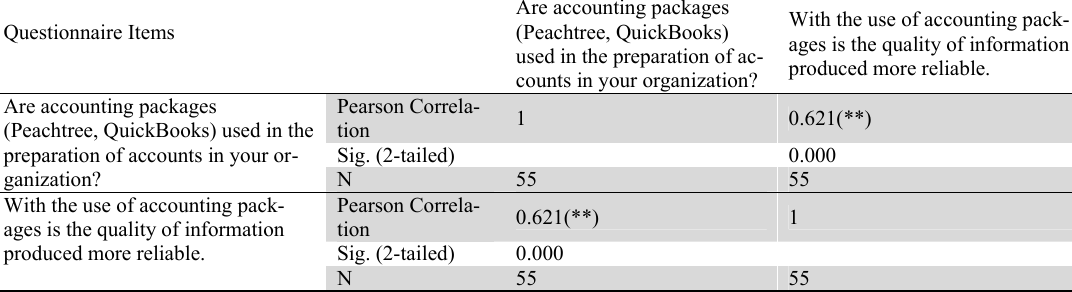
Correlation results of ICT Adoption and Accounting System of